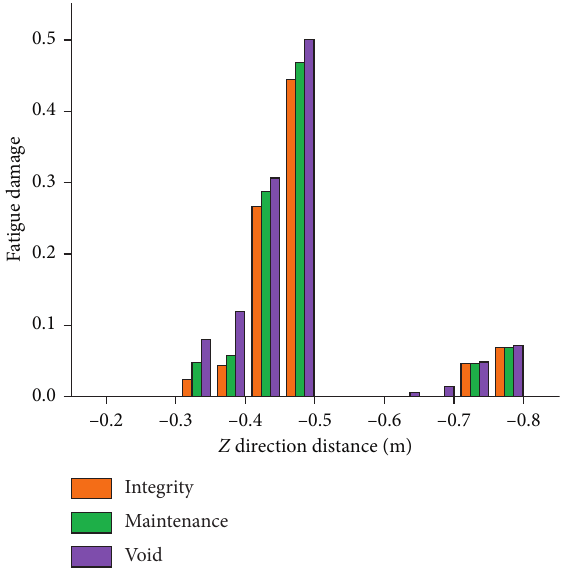
Figure 19: Fatigue damage distribution in Z direction corre- sponding to three working